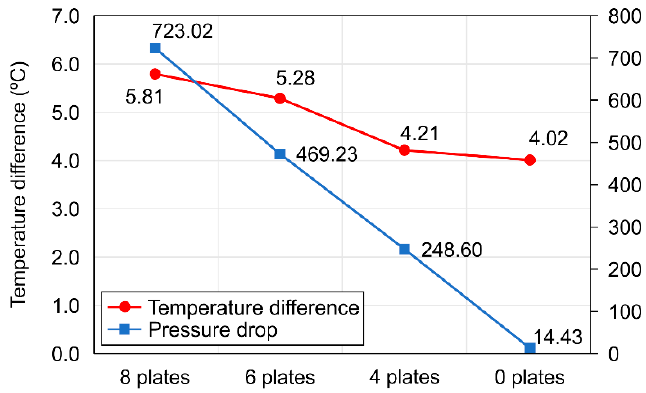
Figure 10. The temperature differences between x = 0 m and x = 20 m for various plate quantities.